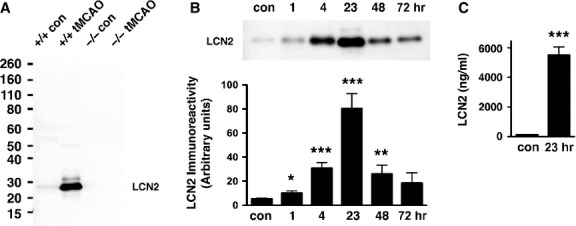
Induction of LCN2 in mouse serum after ischaemic stroke. (A) Mouse sera collected from Lcn2+/+ and Lcn2−/− mice after 1 hr of tMCAO and 23 hrs of reperfusion were analysed by western blotting using anti-LCN2 antibody. The serum of mice without tMCAO was collected as a control (con). (B) Mouse sera collected at different time-points after 1 hr of tMCAO were analysed by western blotting using anti-LCN2 antibody. The top panel is a representative Western blot. The LCN2 protein bands were quantified by densitometry in the bottom panel (n = 3–6). There was a significant induction of LCN2 at 1 hr (*P < 0.05), 4 and 23 hrs (***P < 0.0005) and 48 hrs (**P < 0.005) after tMCAO compared with control (two-tailed, unpaired t-test). (C) Levels of LCN2 in control mouse sera and at 23 hrs after tMCAO were determined by ELISA (n = 7). ***P < 0.0001 compared with control (two-tailed, unpaired t-test).